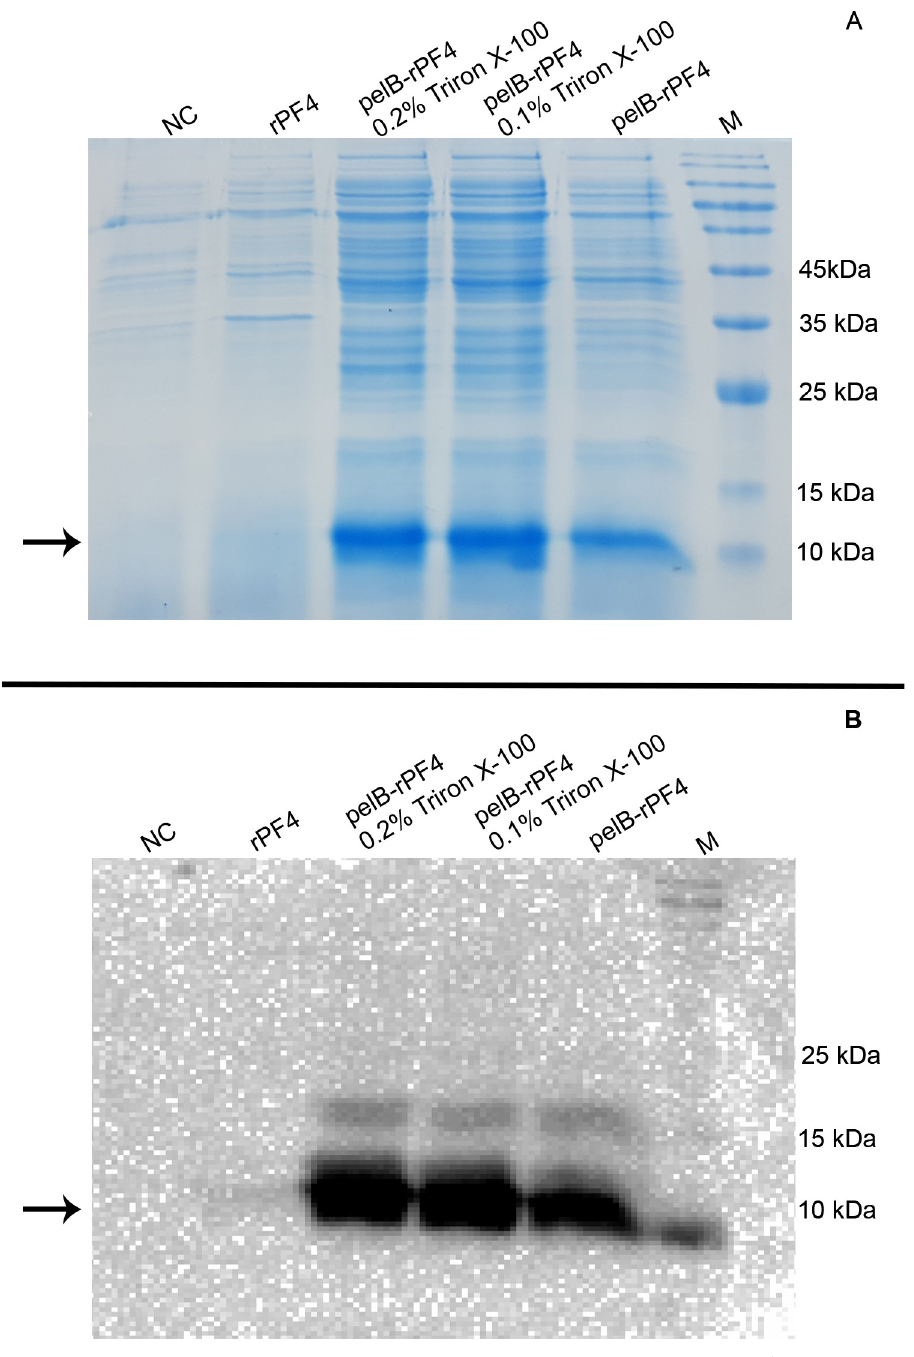
Fig 6. Confirmation of the rPF4 secretion into the outside medium using Western blotting. The rPF4 protein secreted into the extracellular milieu via the T2SS was subjected to SDS-PAGE (A) and Western blotting (B). Triton X- 100 supplementation at low concentrations was found to increase protein secretion compared to the cultures lacking any Triton. The slight background regarding the pET26b-rPF4 construct is likely due to the cellular rupture during the 48-h cultivation or sample preparation. NC represents the negative control which lacks the rPF4 coding sequence. The arrow indicates the rPF4 protein band. M denotes the molecular weight marker.